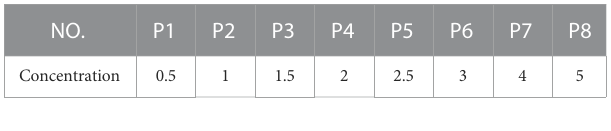
TABLE 4 Concentration of SHMP solution (%).